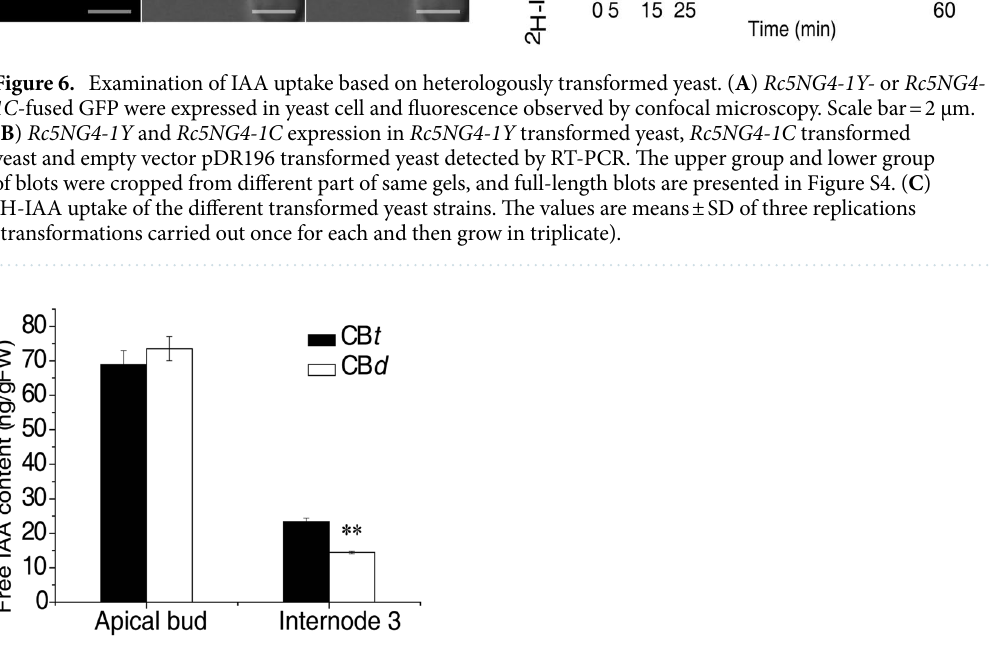
Figure 7. Measurement of free IAA concentration in CB t and CB d . The free IAA concentration within apical bud and Internode 3 were measured using CB t and CB d seedlings with seven internodes. Values are means ± SD of three replicate determinations, ** p value ≤ 0.01(Student’s